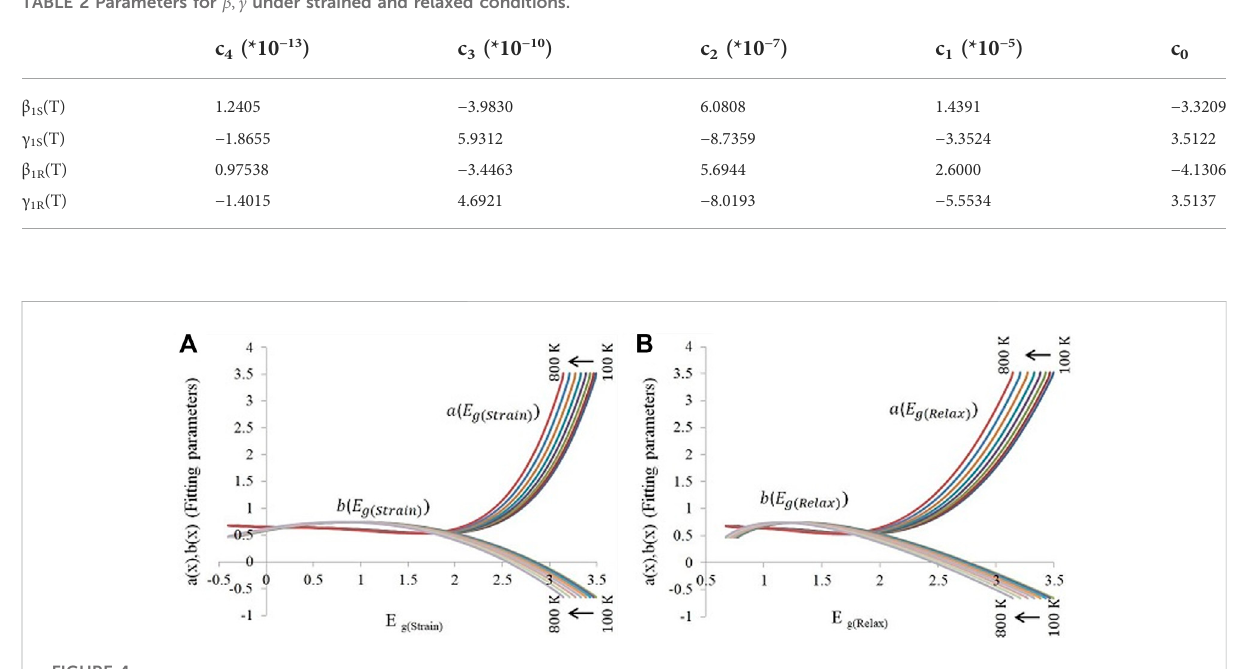
FIGURE 4 Fitting parameter for the absorption coef fi cients for (A) InGaN strained to GaN and (B) bulk relaxed InGaN at different temperatures.